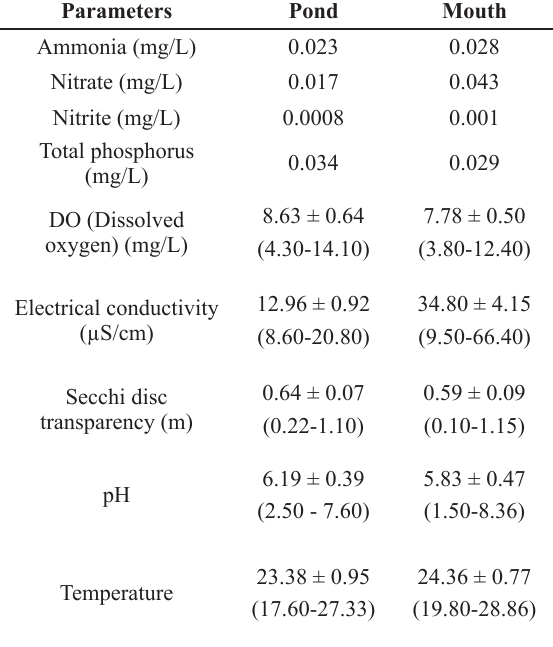
Environmental characterization of the sampling stations in the lower course of the Peixe River, municipality of Anhembi (SP), under the influence of the Barra Bonita Reservoir (middle Tietê), during the collection period.